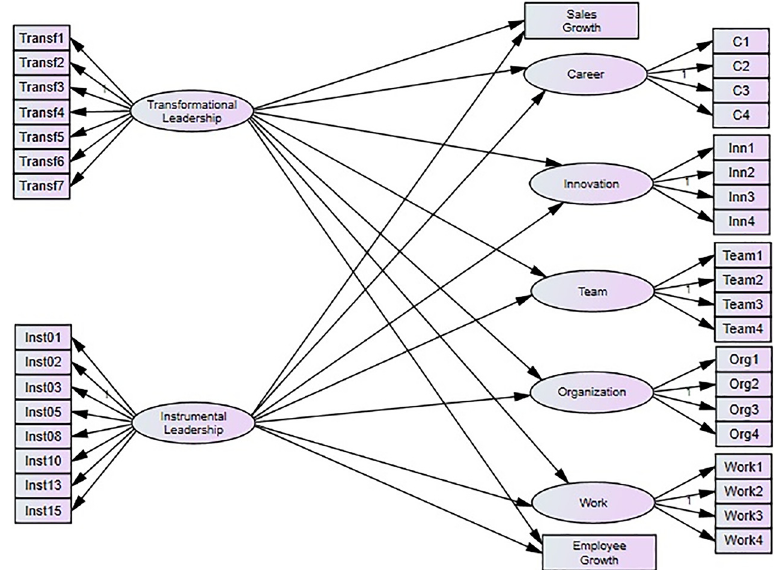
Figure 2. The complete